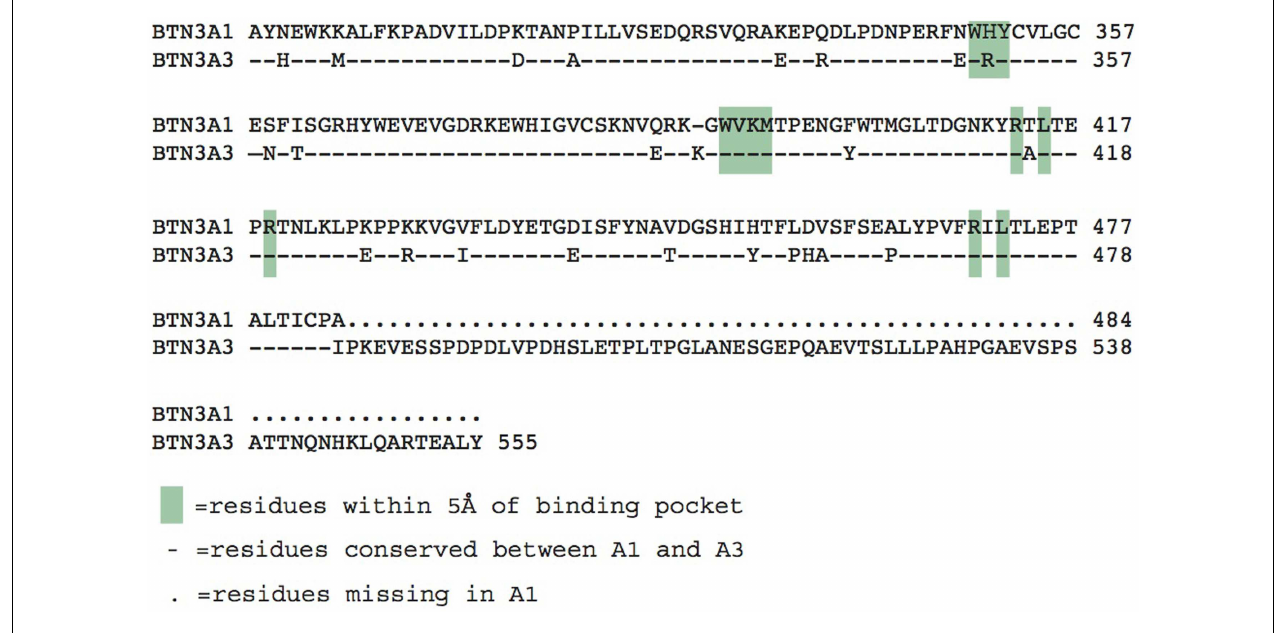
differences are shown in their single letter abbreviations. Green boxes indicate residues within 5Å of the phosphoantigen binding pocket. BTN3A3 has an additional polypeptide